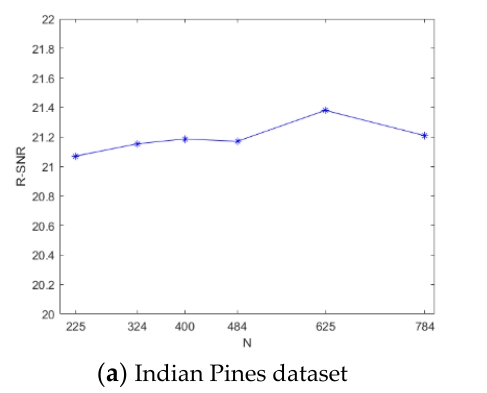
Figure 10. R-SNR varies with different N on two